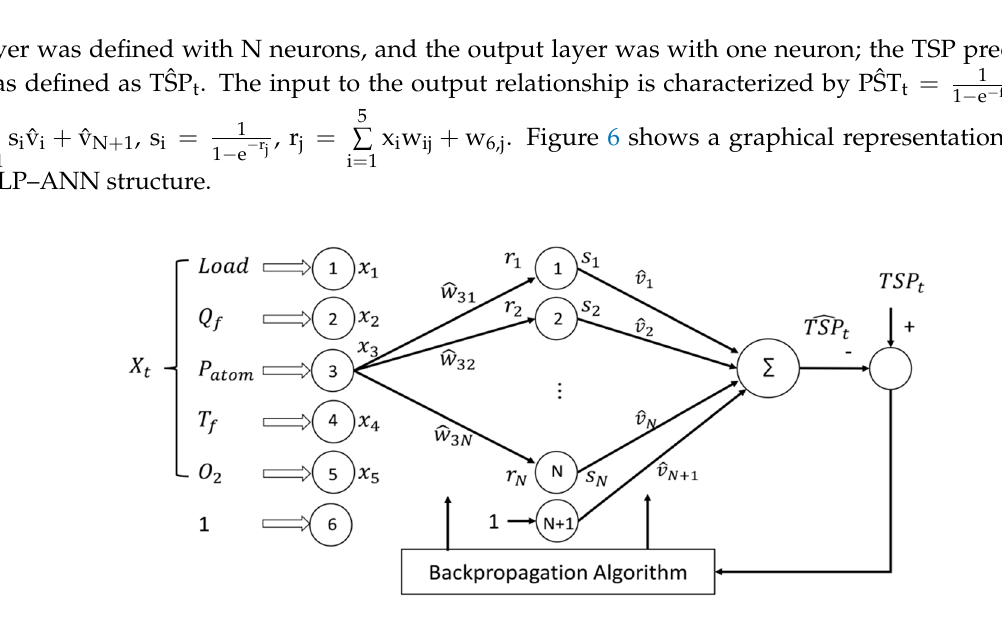
Figure 6. MLP–ANN model structure for TSP modelling.